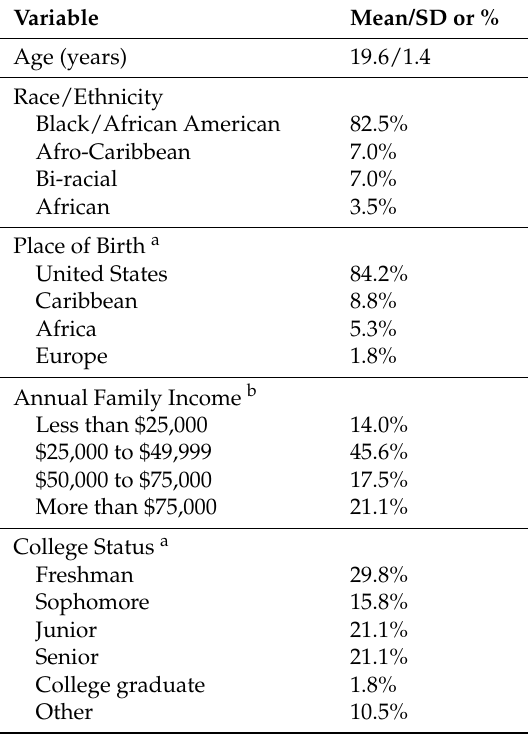
Table 1. Demographic Characteristics of the Sample ( N =